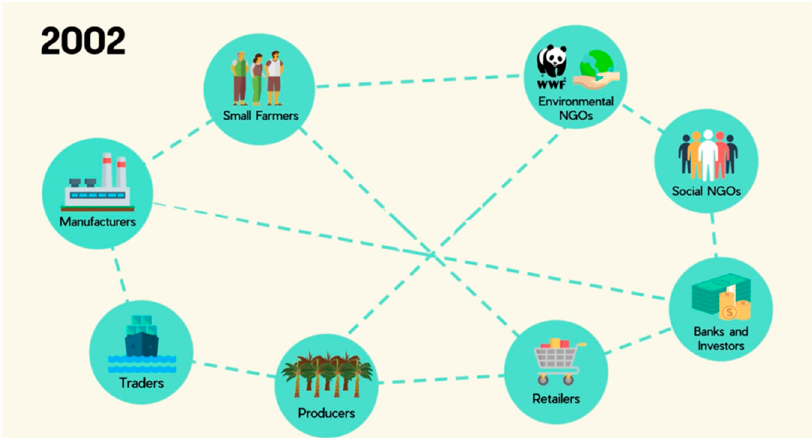
Figure 3. Multistakeholder Governance Initiatives, Roundtable on Sustainable Palm Oil (2020). A “common governance environment” with multilateral actors and global alliances, for improving the sustainable production and trade of palm oil product, has existed since 2002.